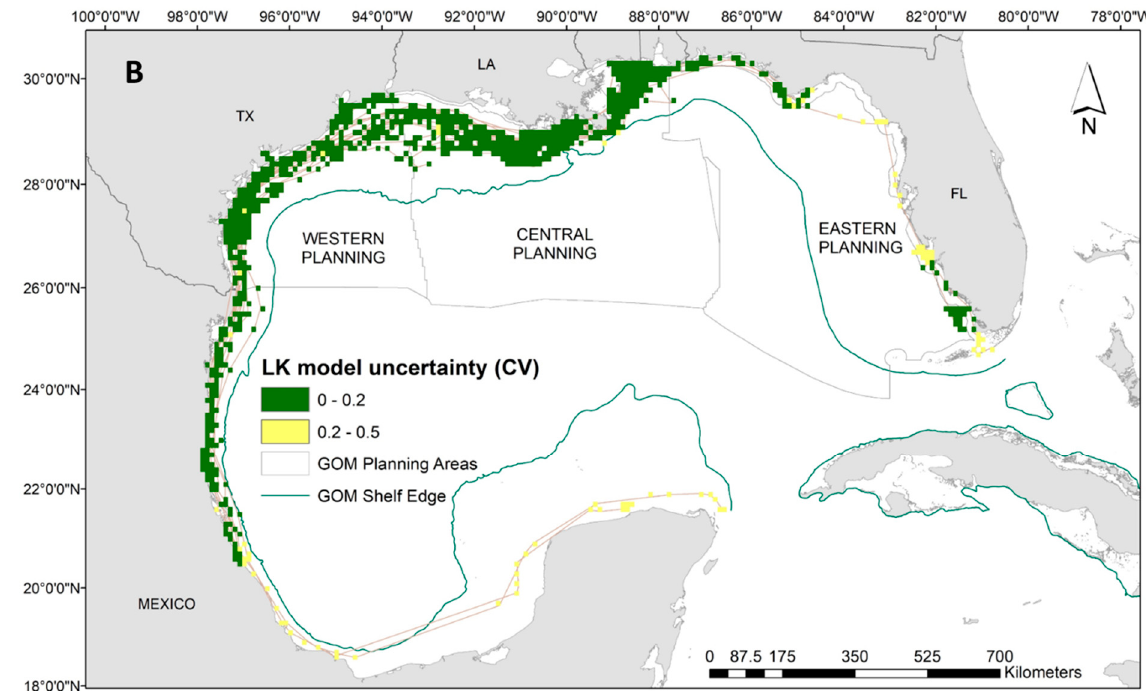
Figure 4. ( A ) Spatial predictions and ( B ) associated model uncertainty, represented by coefficient of variation (CV), for Kemp’s ridley turtles ( Lepidochelys kempii ) time-at-surface model. Disparity in Kemp’s ridley tracking footprint compared to loggerheads or greens is due to tagging locations predominantly located in the western Gulf of Mexico. Time-at-surface predictions can be interpreted as a percentage of 100% for a 24 h observational time window. Predictions from both training and testing data are displayed but were generated independently.